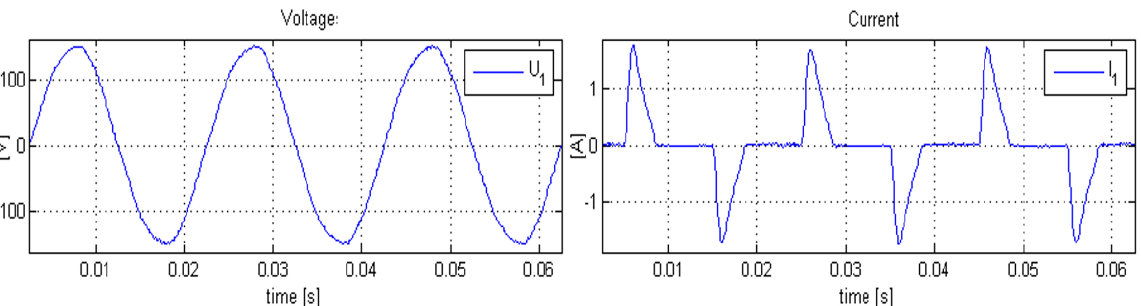
Figure 7. Waveforms acquired with a sampling frequency of 19.2 kHz. ( Left )—voltage drop across terminals, ( right )—currents absorbed by EUT [16].